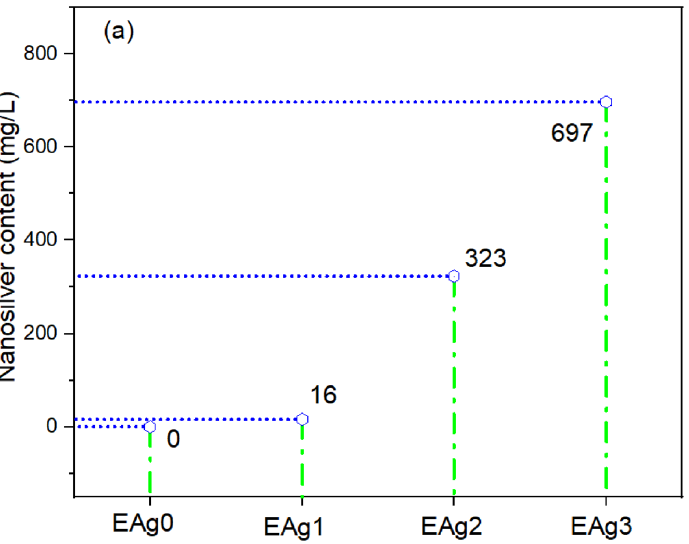
Figure 3. iCP OES test analysis for nanocolloids developed over sisal/cotton interwoven